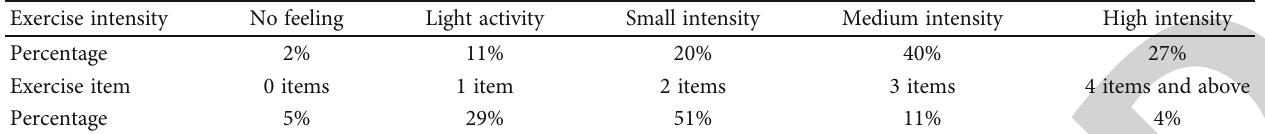
Table 3: Physical exercise intensity and exercise items of college students.